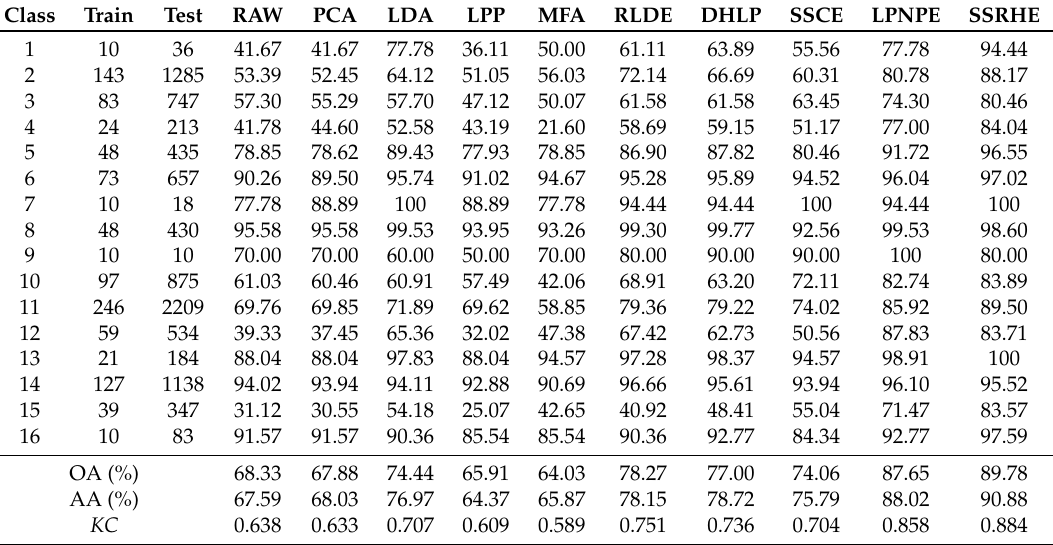
Table 3. Classification results of different classifiers on the Indian Pines